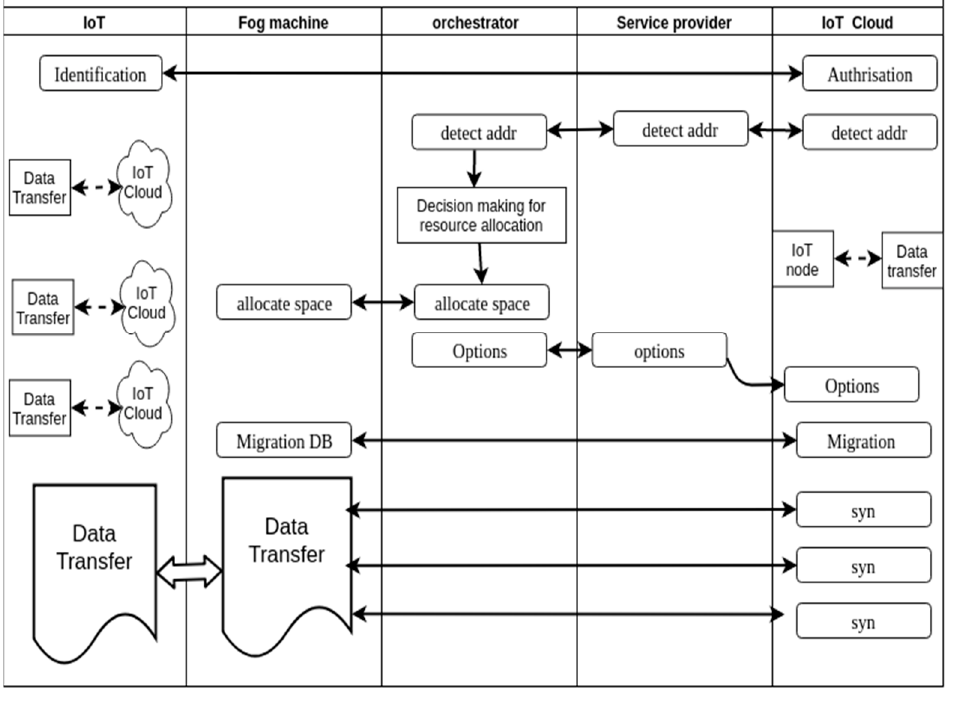
Figure 4. The data flow algorithm.